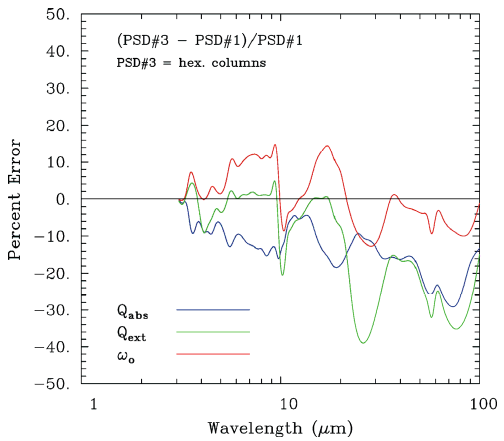
Figure 10. Wavelength dependence of optical property errors for a PSD (not shown) having the Fig. 10. Wavelength dependence of optical property errors for a same D e and IWC as the measured PSD but containing only hexagonal columns, relative to the PSD (not shown) having the same D e and IWC as the measured measured PSD (PSD #1). PSD but containing only hexagonal columns, relative to the mea- sured PSD (PSD